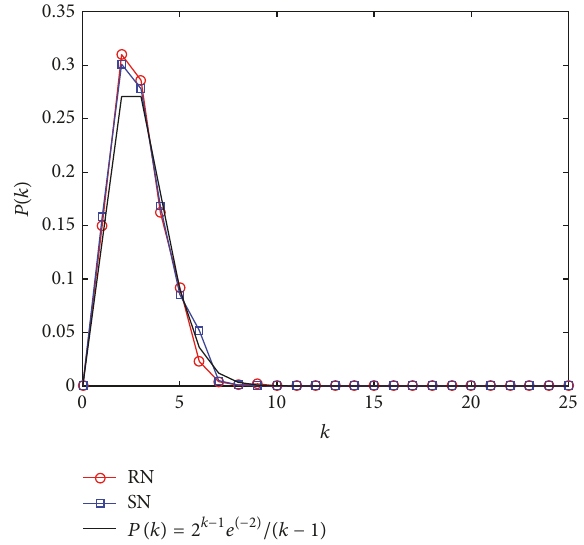
Figure 3: Degree distribution of random network and small-world network.